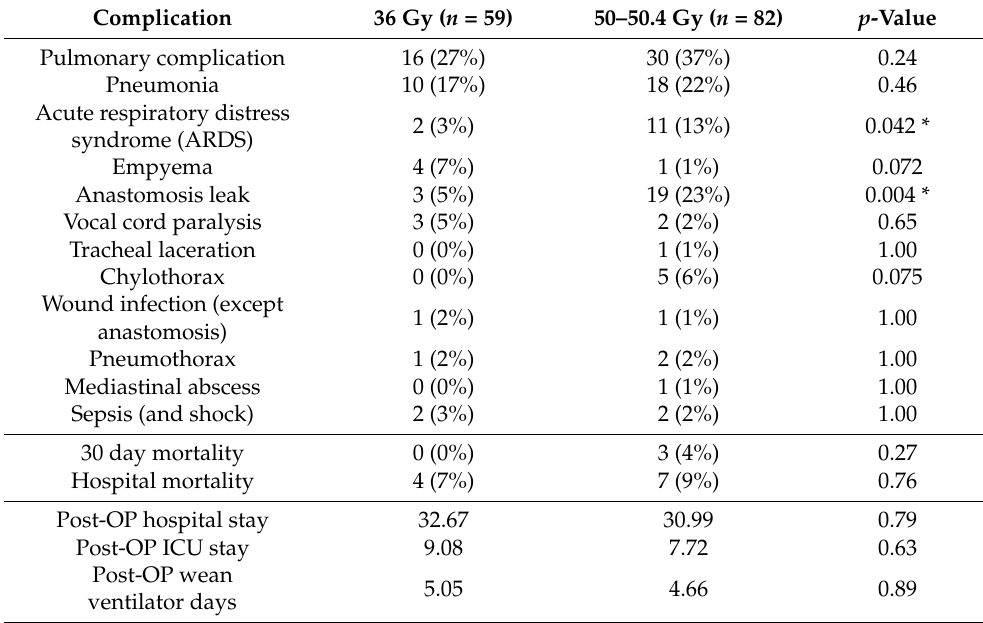
Table 6. Surgical complications and mortality after esophagectomy in 141 patients with 7th AJCC stage III esophageal squamous cell carcinoma receiving preoperative